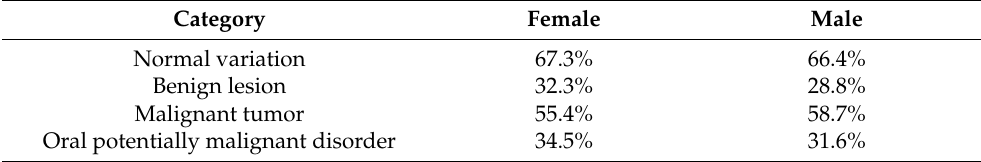
Table 1. Percentage of correct answers per category according to gender.